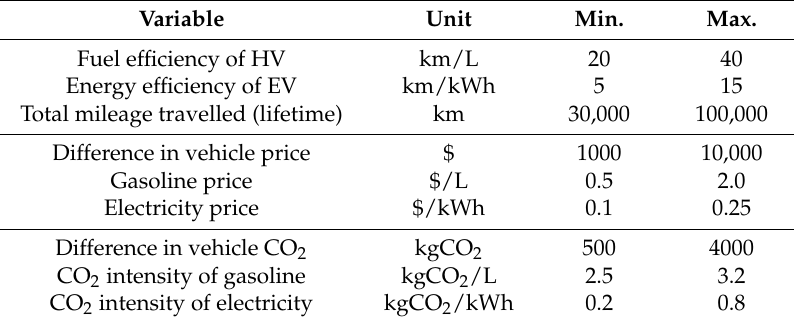
Table 1. Ranges of variables for LCC analysis.